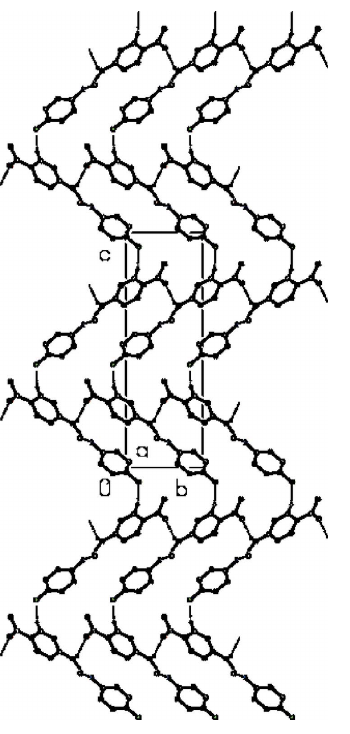
(14) and R 2 (26) ring 2 4